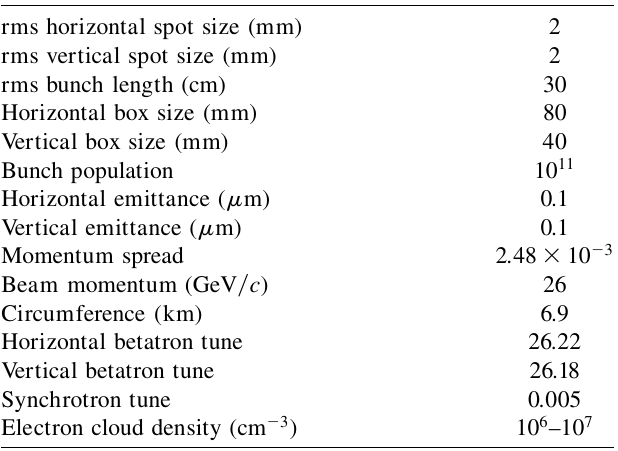
TABLE I. SPS parameters used in the